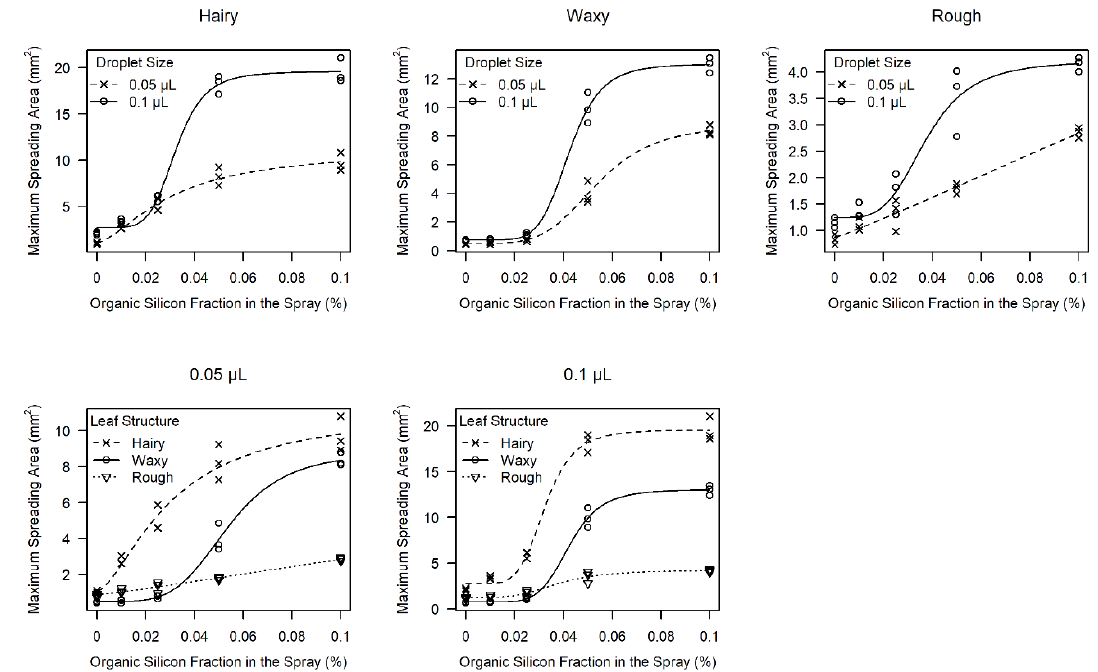
Figure 4. The comparison of the maximum spreading area of the droplets with organic silicone. The results were grouped under the leaf surface structures and the droplet sizes in each sub-figure. The droplets were prepared with the spray mixture containing the surfactant of the organic silicone with the volume fraction of 0%, 0.01%, 0.025%, 0.05%, and 0.1%. The spot marks represent the average value of each treatment in one repeat of the experiment. For the leaf structure, the group names Hairy, Rough and Waxy represent the leaves of D. sophia, L. temulentum and L. lotifolium respectively .